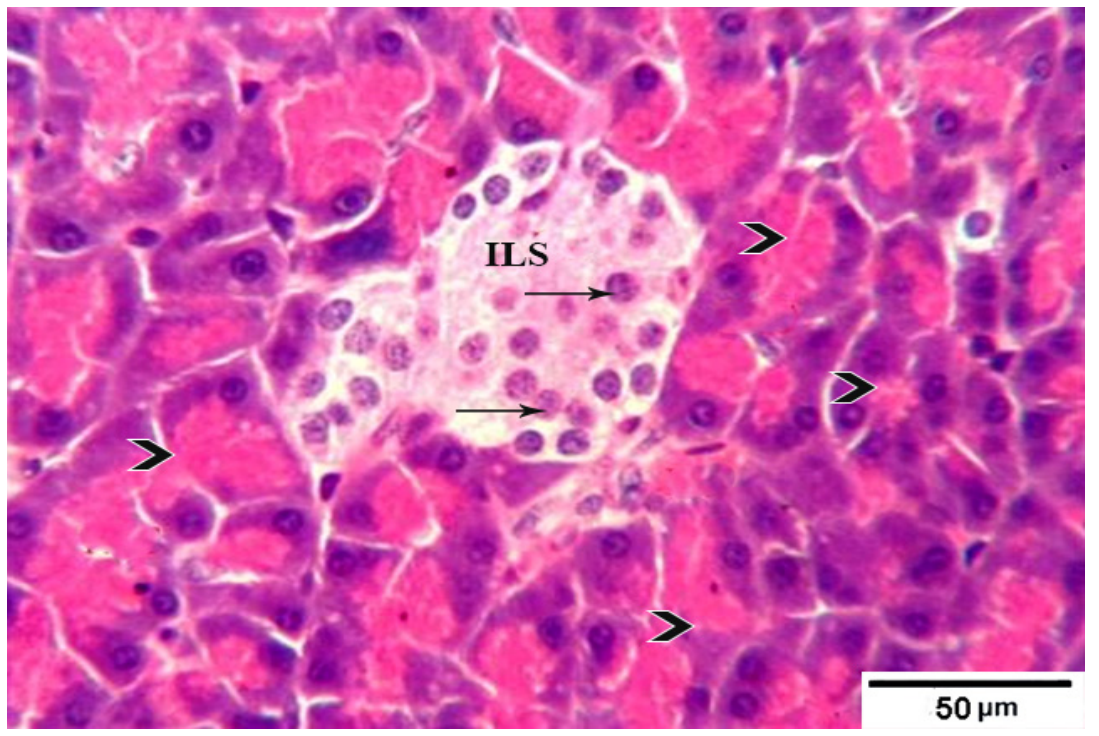
Figure 4. Photomicrograph of pancreatic tissue sections from treated group 4 rats showing islets of Langerhans (ILs) restored its normal size and with normal cellular structure and density (arrows) in between intact normal acidophilic pancreatic acini (arrowheads) H&E stain. The bar size is indicated under